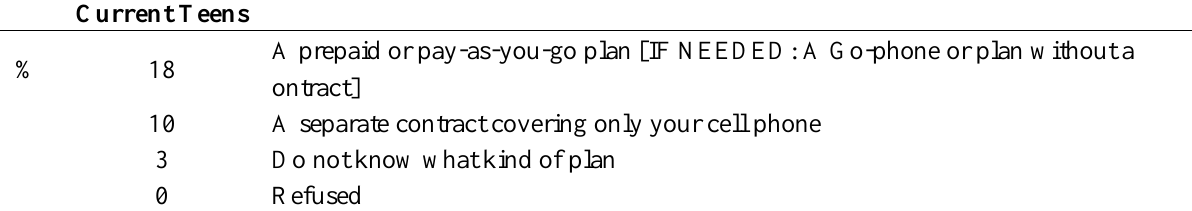
Table A6. What kind of cell phone plan do you have? Is it…[READ]? (Based on teen cell users [ N = 625]).